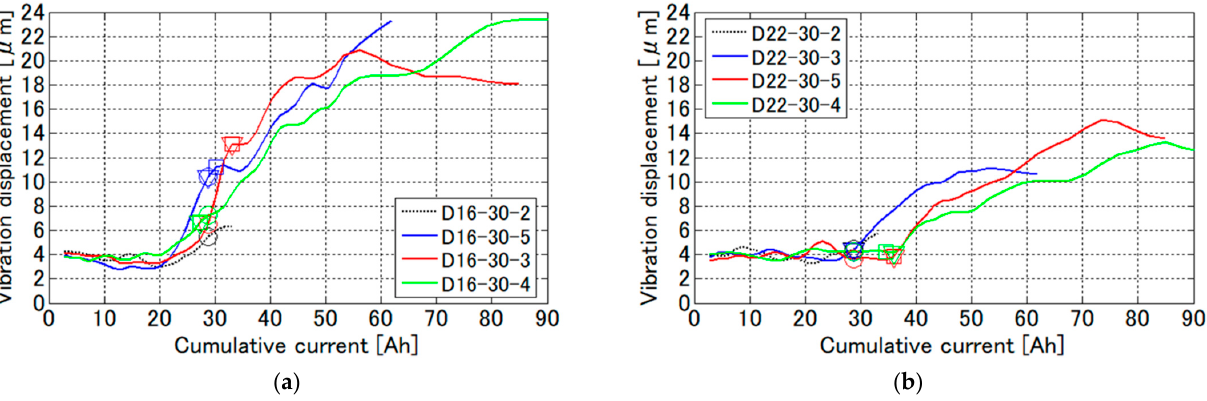
Figure 14. Rebar vibration displacement measured by VDR in the electrolytic corrosion test for: ( a ) D16 rebar; and ( b ) D22 rebar. The markers indicated by a circle, rectangle, and triangle mean the timing at occurrence of cracks on the top surface, that on the side surfaces of the concrete, and leakage of rust water from the crack, respectively.